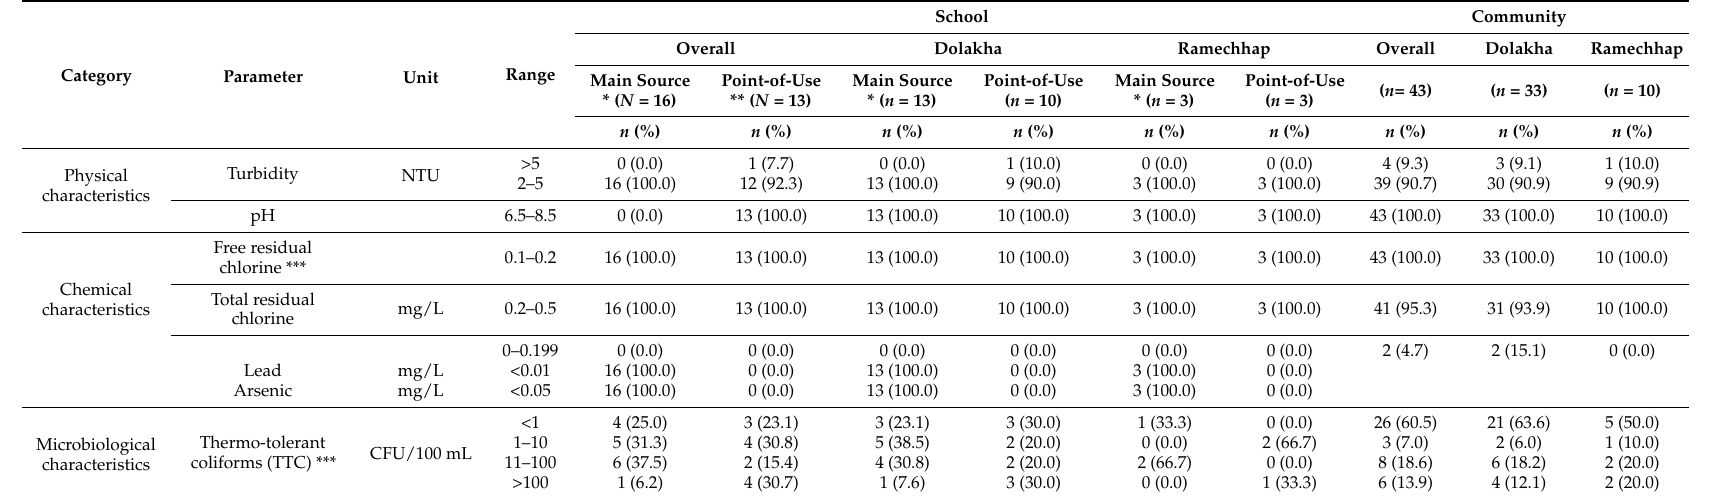
Table 3. Physicochemical and microbiological parameters of water samples in school and community in Dolakha and Ramechhap districts, Nepal (sampling period: May and June